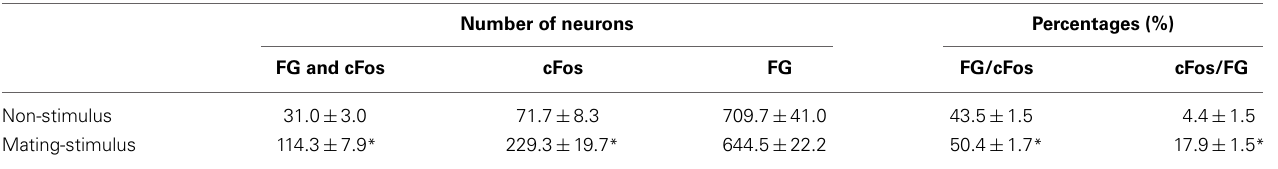
Table 1 | Numbers and percentages of FG and cFos immunoreactive neurons in the lateral PAG in female rats after FG injection into the RF with or without mating stimulus.